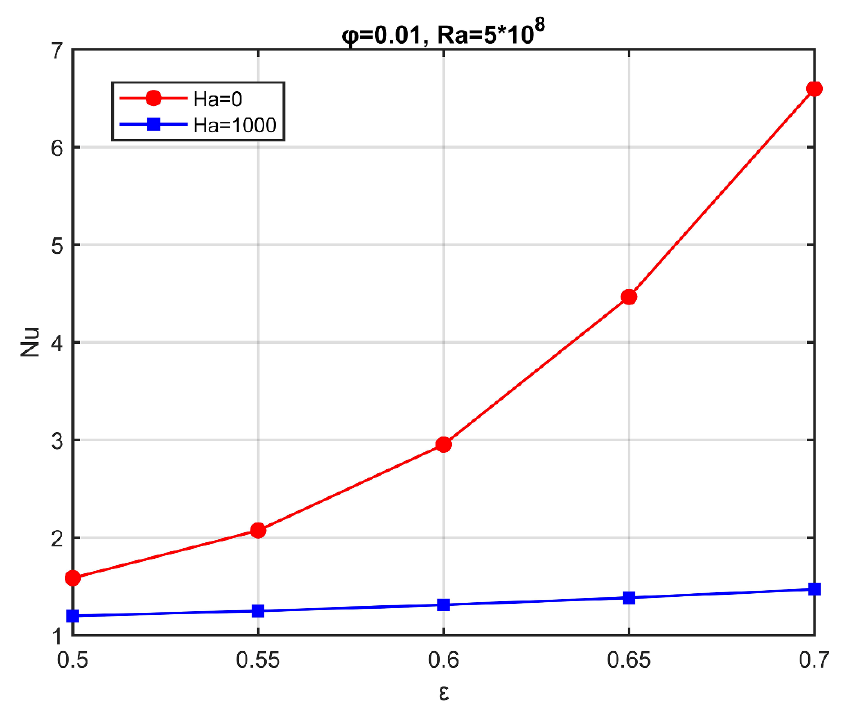
Figure 5. Average Nusselt number variation with porosity for two characteristic Hartmann numbers. Ra = 5 × 10 8 ; ϕ = 0.01 .